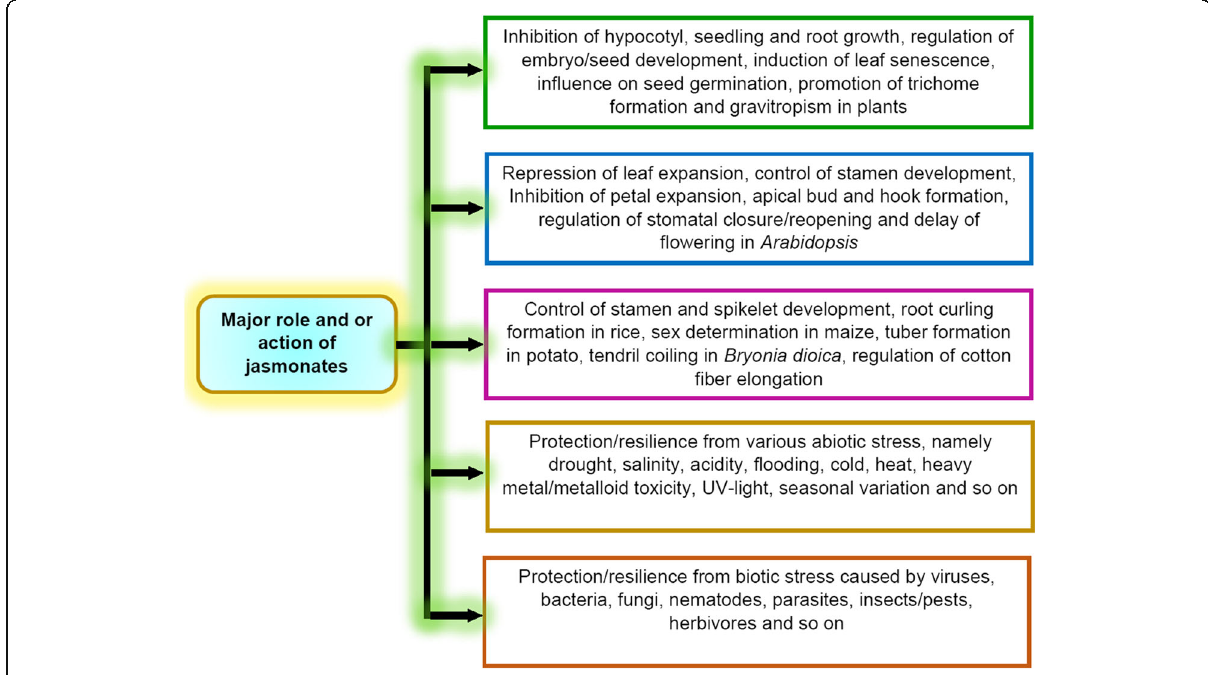
Fig. 1 The role of JAs on plant growth and developmental